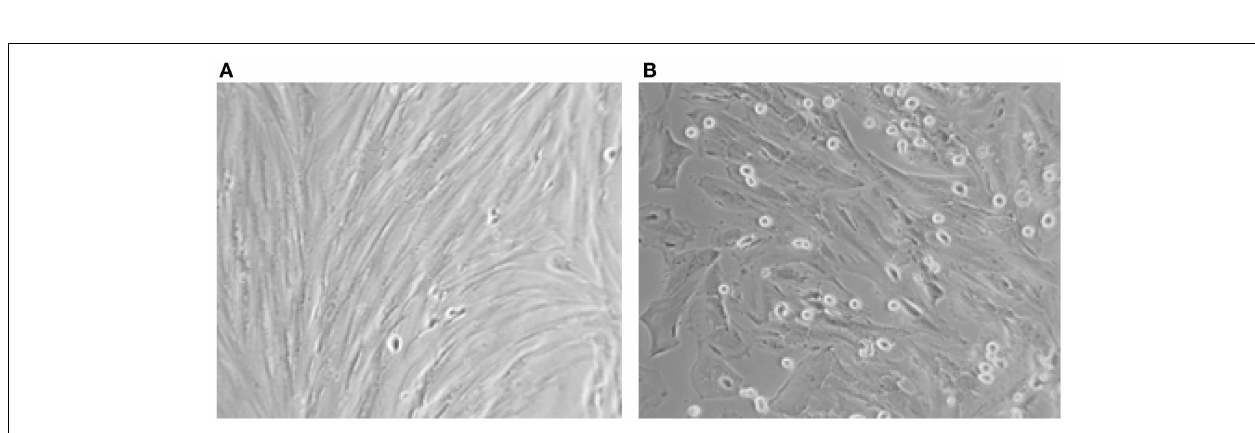
FIGURE 2 | Immuno-cytochemical localization of cytokeratin (A), vimentin (B), estrogen receptor (C), progesterone receptor (D), androgen receptor (E) and factorVIII (F) proteins in cultured endometriotic cells